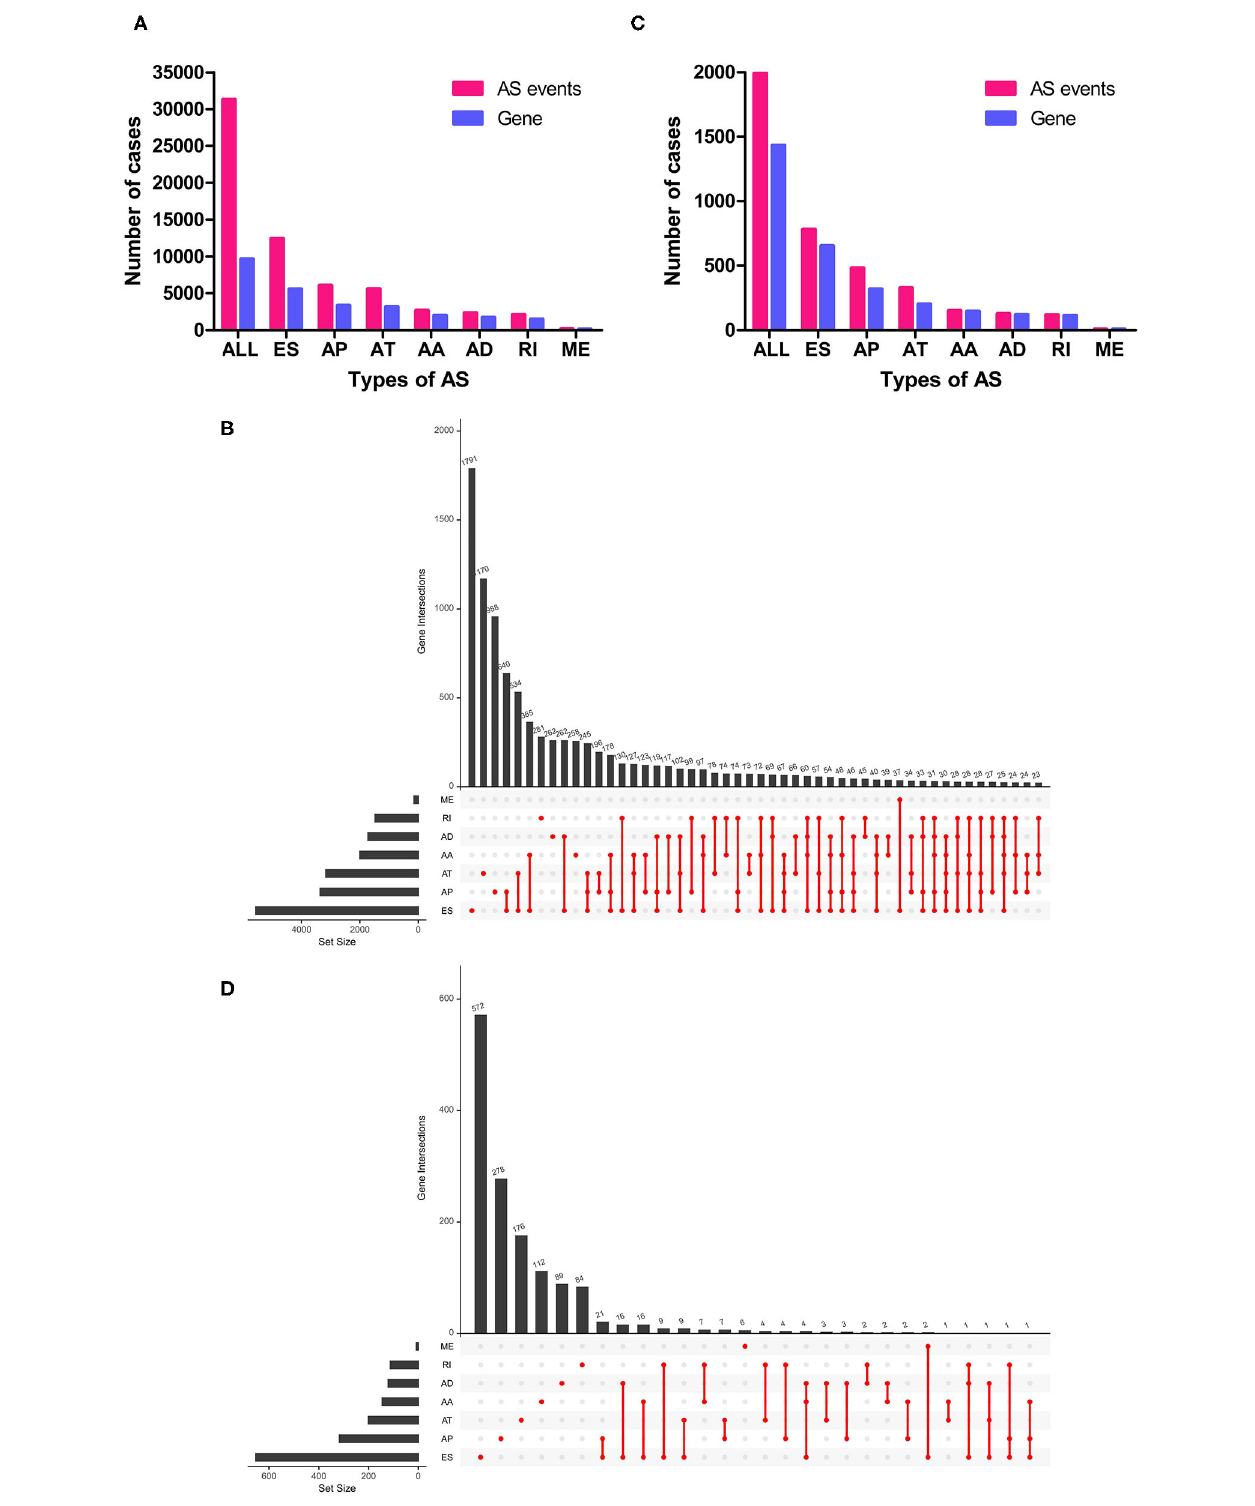
FIGURE 1 | Overview of AS events in LUSC patients. (A) Numbers of AS events and parent genes for each AS type in LUSC patients. (B) Upset plot of interactions among seven types of all AS events in LUSC patients. (C) Numbers of survival-related AS events and parent genes for each AS type in LUSC patients. (D) Upset plot of interactions among seven types of survival-related AS events in LUSC patients. AS, alternative splicing; LUSC, lung squamous cell carcinoma.